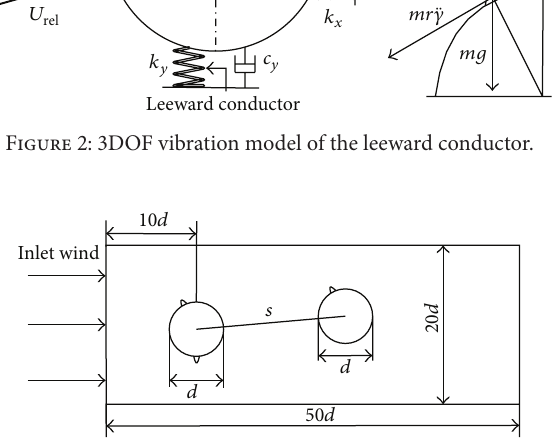
Figure 3: Computational domain of the bundled conductors with